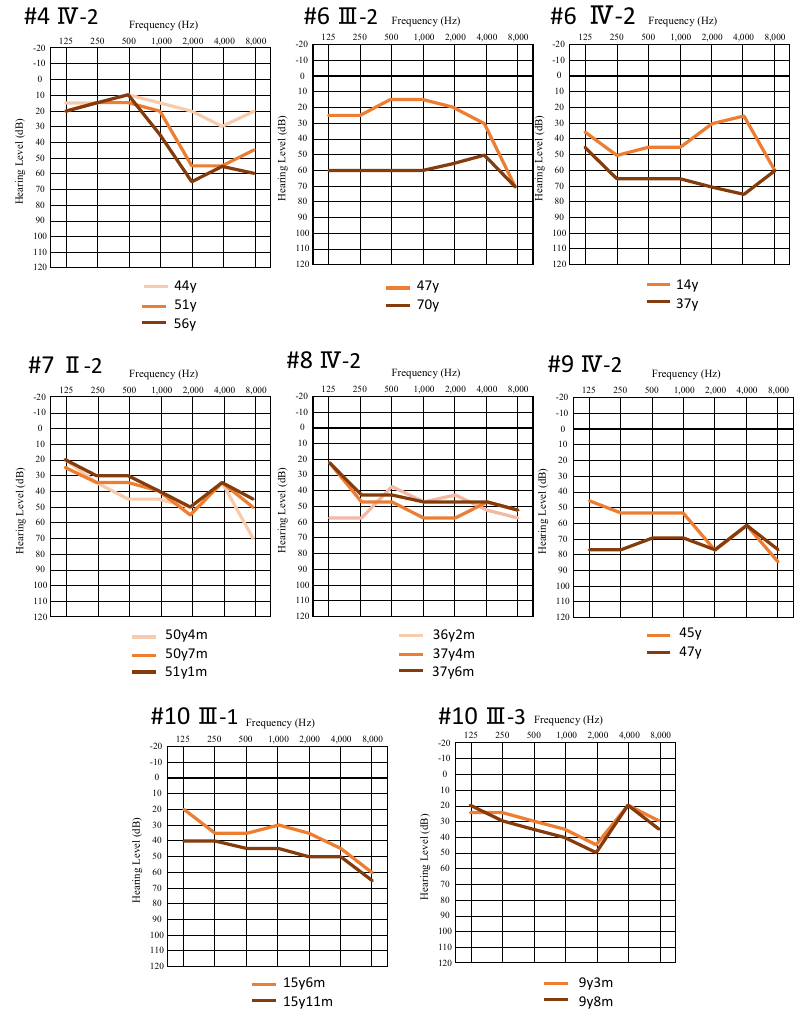
Figure 3. Serial audiograms of eight individuals from six families with MYH14 variants.